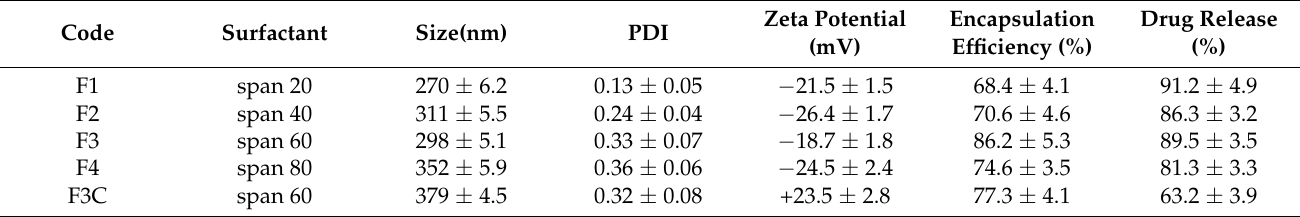
Table 2. Physicochemical evaluation results of IPI vesicles and IPI chitosan vesicles. Each study performed in triplicate and the data shown as mean ± SD, ( n =